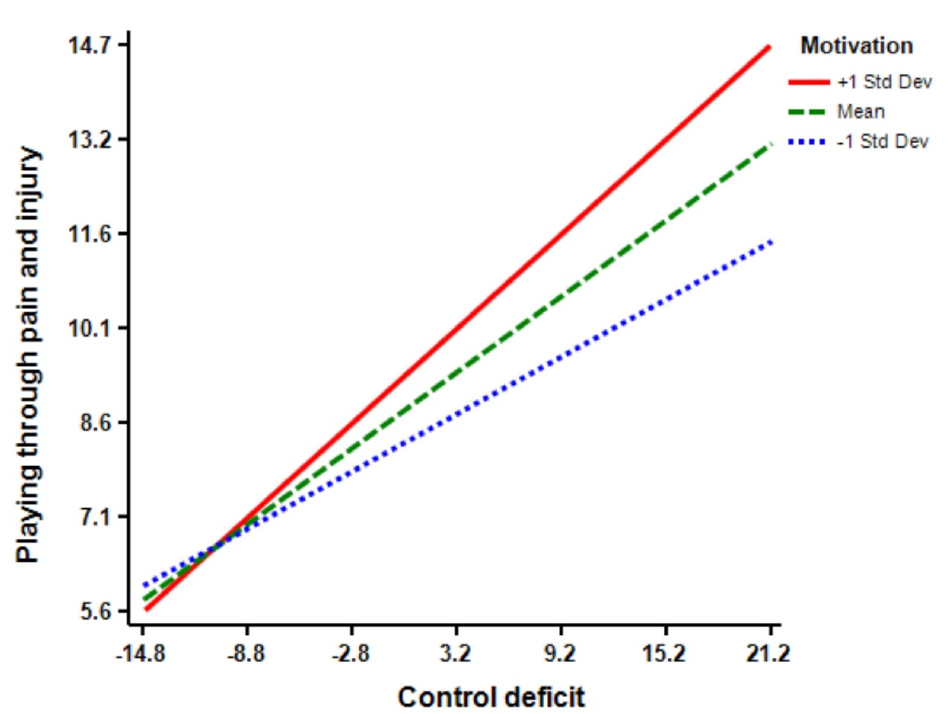
Figure 5. Motivation by control balance deficit interaction.